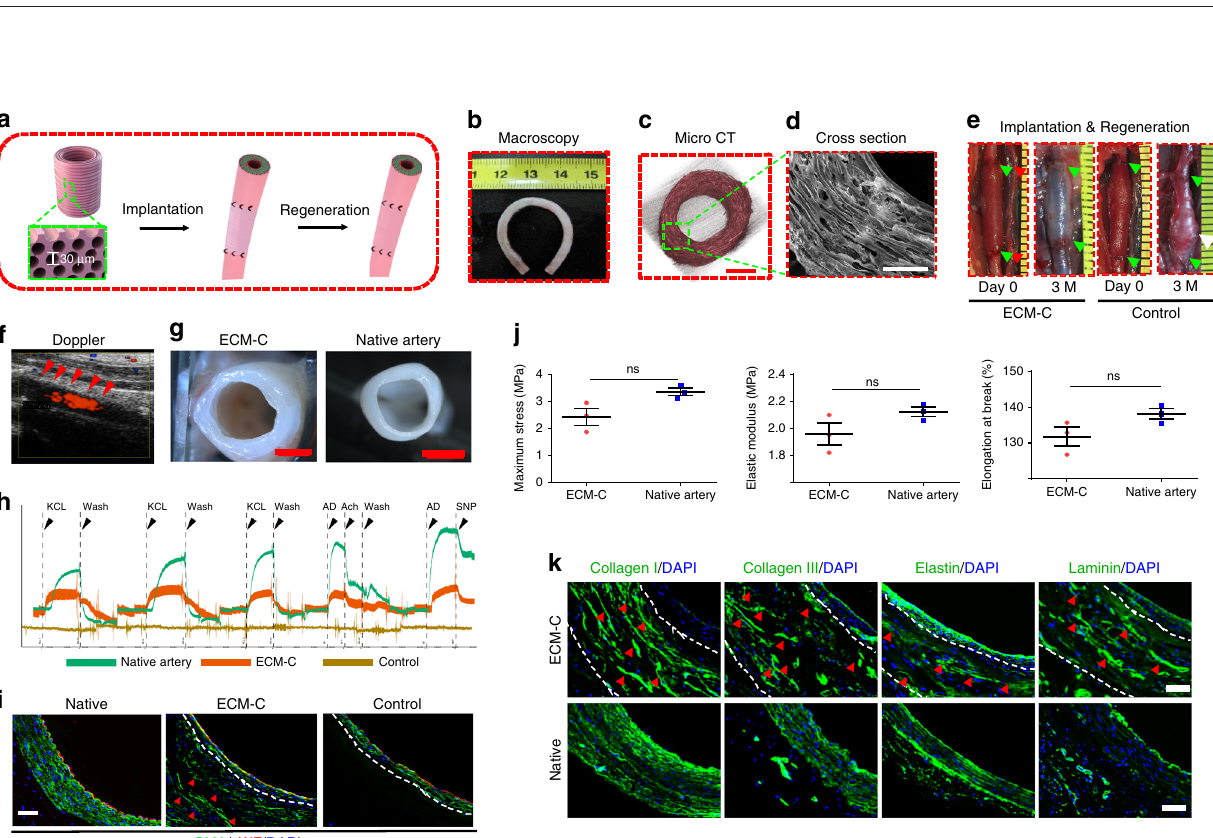
Fig. 6 Characterisation and utility of tubular scaffolds (ECM-C, control scaffolds and autografts) for nerve regeneration at 3 months. a Schematic illustration of implantation of tubular nerve ECM-C scaffolds for nerve regeneration of the rat sciatic nerve defects. b Macroscopic appearances and microstructures (MicroCT and SEM) of tubular scaffolds. Insets indicate the shape of obtained scaffolds. c , d Macroscopic view of the implanted (day 0) and regenerated nerves (3 months) by ECM-C and control scaffolds in rat sciatic nerve defects. e H&E staining of the transverse sections of regenerated nerves showing the distribution of regenerated capillaries and myelinated fi bres in the scaffolds. Black arrows indicate the capillaries. Black and red boxed images are the magni fi ed region of interior and wall of the explanted scaffolds. f , g Semi-quanti fi cation of capillaries in the interior and the wall of various scaffolds. h Immuno fl uorescence staining of the transverse sections of the explanted scaffolds con fi rmed that the myelinated fi bres were positive for NF09 (green) and S100b (red). i , j The number of myelinated fi bres and the CMAPs amplitude among various scaffolds ( n = 5 animals per group). k Transmission electron micrographs of the transverse sections from various groups. l , m Comparison of the thickness of regenerated myelin sheath and diameter of regenerated myelinated fi bres ( n = 5 animals per group). n Masson trichrome staining of the cross-sections showing the morphology of gastrocnemius muscle. o , p Average diameter of muscle fi bres and wet weight of gastrocnemius muscle ( n = 5 animals per group). Bar heights and error bars represent means ± s.e.m. (ANOVA). Statistical analysis (ns = no signi fi cance). Scale bar: b – d macroscopic images, 1 mm; microCT images, 500 μ m; SEM of cross section, 500 μ m; SEM of luminal surface, 100 μ m; e H&E, 200 μ m; Magni fi ed H&E, 50 μ m; h 100 μ m; k 5 μ m; n 50 μ m